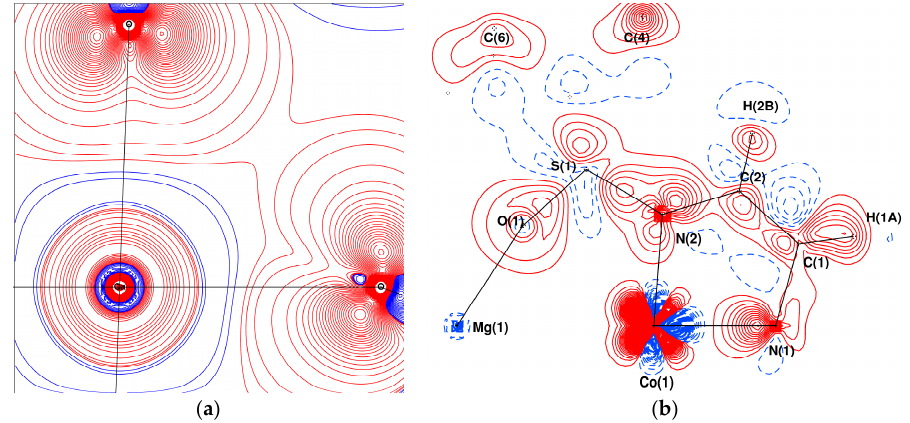
Figure 3. ( a ) A deformation electron density map in the plane of the Ca 2+ atom and two of the oxygen donor atoms. The density is almost perfectly spherical about the calcium, and two lobes of density corresponding to the two pairs of lone-pair electrons about each oxygen atom are visible. Red lines represent positive contours, and blue lines represent negative contours. Contours are drawn at 0.1 eÅ − 3 intervals. ( b ) A deformation electron density map in the plane of the Co 2+ atom and two of the nitrogen donor atoms. Four charge concentrations corresponding to the d electrons about the cobalt atoms are visible, and two of these are larger towards the Mg 2+ ion. Red lines represent positive contours, and blue lines represent negative contours. Contours are drawn at 0.1 eÅ − 3 intervals.